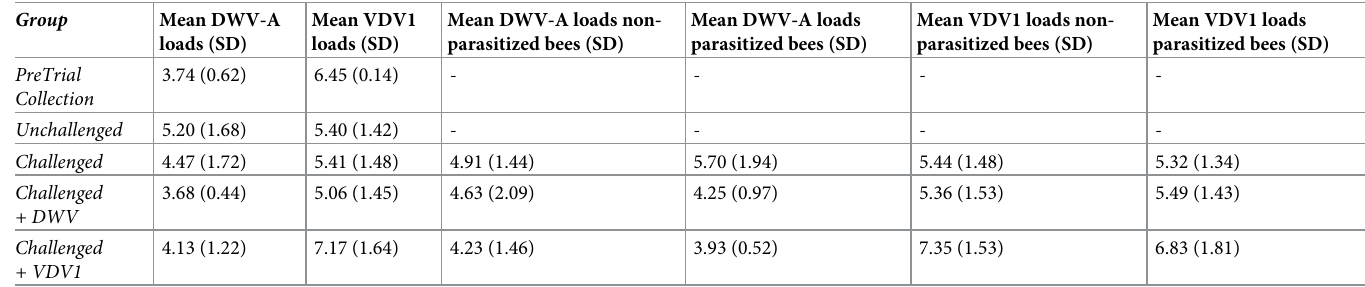
Table 6. Mean viral loads DWV-A and VDV1 across experimental groups (log 10 GE per bee). Means ± SD for DWV-A and VDV1 viral loads provided in order from the group and within parasitized and non-parasitized cohorts. Analysis can be found in subsequent Tables A and B in S1 Tables.